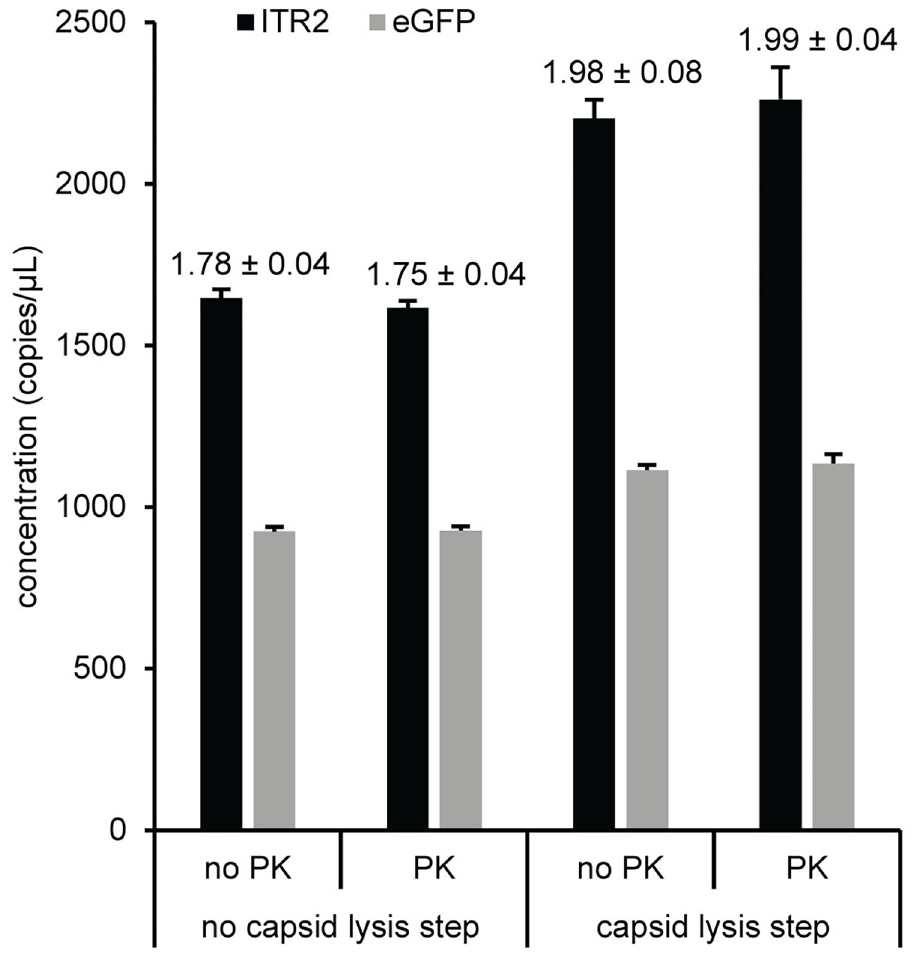
Fig 7. Effect of proteinase K on AAV5. After DNase I digestion, AAV5 was incubated either without (no PK) or with (PK) proteinase K for 2 hours at 50˚C and then further processed as described in the Materials and Methods. The two samples were serially diluted in parallel with polyA+ buffer and either added directly to the ddPCR supermix (no capsid lysis step) or had the capsid thermally lysed (with capsid lysis step) prior to adding to the ddPCR supermix. The ITR2 concentration (black bars) and eGFP concentration (gray bars) is shown. The values indicate the ITR2/eGFP concentration ratio. The error bars and numerical errors represent the 95% confidence interval.